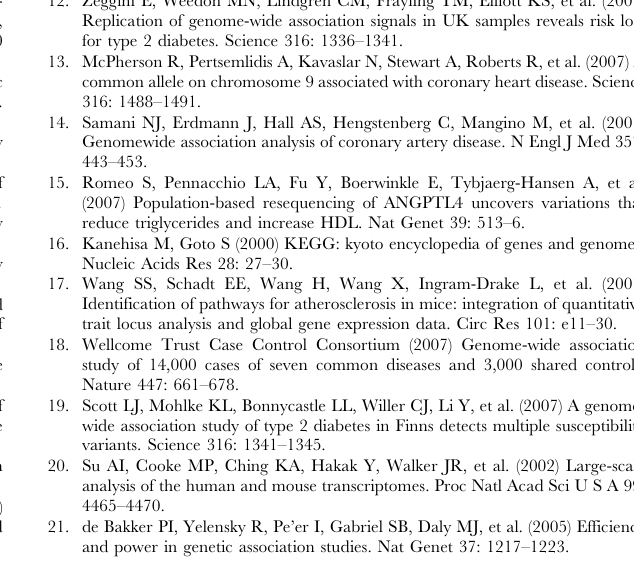
Table S2 Observed IBCv1 Mendelian consistency across 25 HapMap trios. Observed Parent-Parent-Child (PPC) heritability